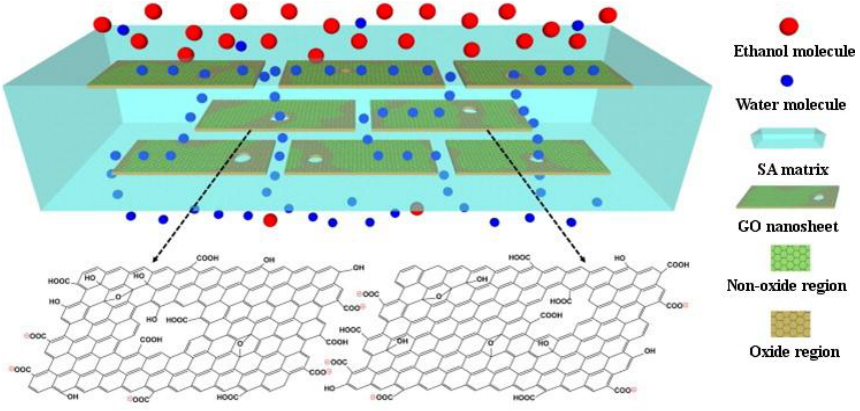
Figure 3. Schematic representation of mechanism for selective water permeation through the hybrid membrane with well-aligned GO nanosheets. Reprinted with permission by Elsevier